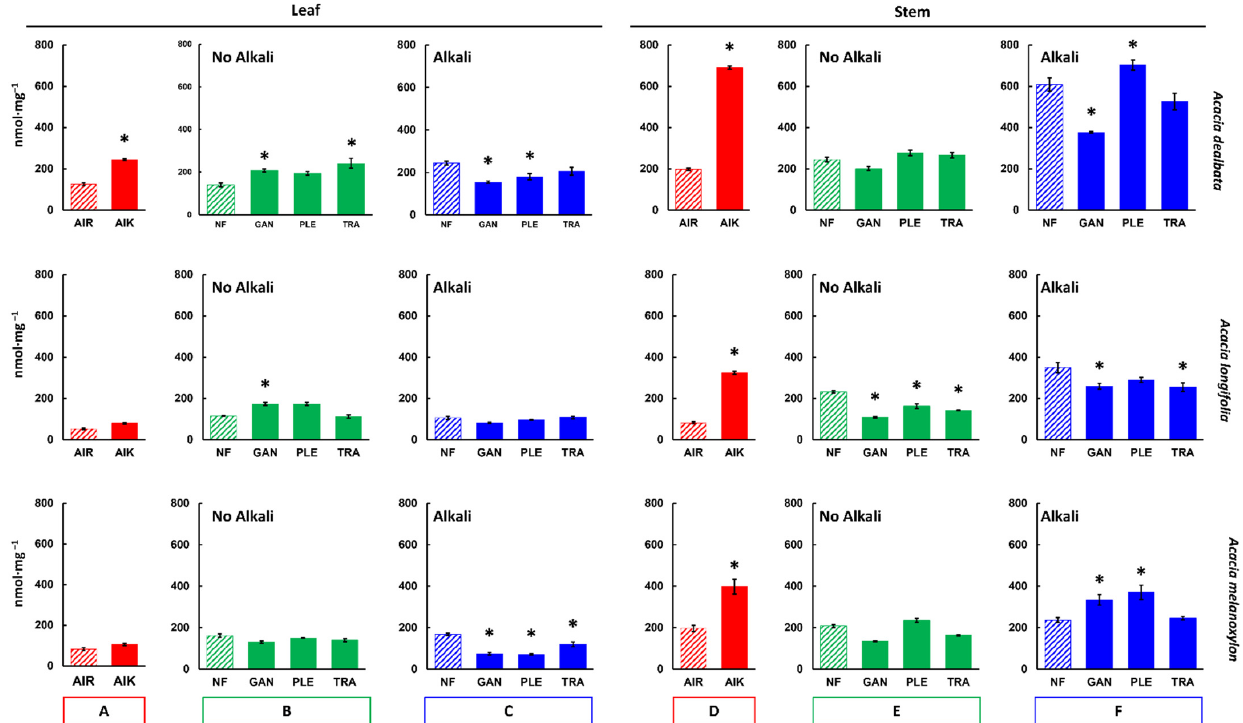
Figure 4. Saccharification of Acacia spp. biomass. Mean nmol of reducing sugar released per mg of biomass material (nmol mg − 1 ) after 8 h incubation in a hydrolytic enzyme mixture. Red bars ( A , D ) refer to non-pretreated alcohol insoluble residue samples, without (AIR) or with (AIK), a mild alkali pretreatment. Green bars ( B , E ) refer to samples treated only with white rot fungi (WRF): G. lucidum , GAN; P. ostreatus , PLE; T. versicolor , TRA. Blue bars ( C , F ) designate treatments where the alkali treatment was employed subsequently to the WRF pretreatment. Pairwise t -tests were performed between each treatment and non-pretreated control samples (AIR; or NF, no fungi; striped bars) to evaluate the impact of the pretreatments. The treatments which are significantly different from the controls are marked with a “*” ( p ≤ 0.05). Error bars represent the standard error of the sample replicates. Table 2. Saccharification of leaf and stem biomass (nmol mg − 1 ) from Acacia spp. measured by a